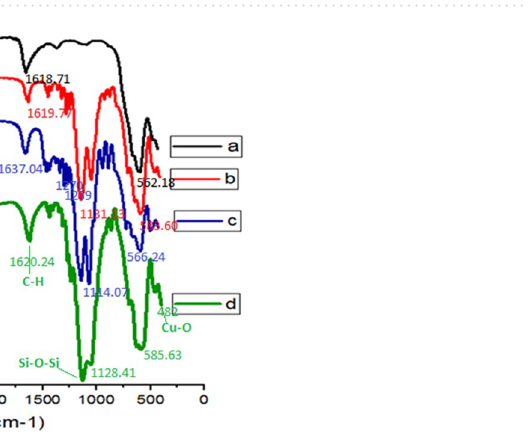
Figure 1. Schematic stepwise preparation of Fe 3 O 4 @Glycerol-Cu magnetic nanocatalyst.